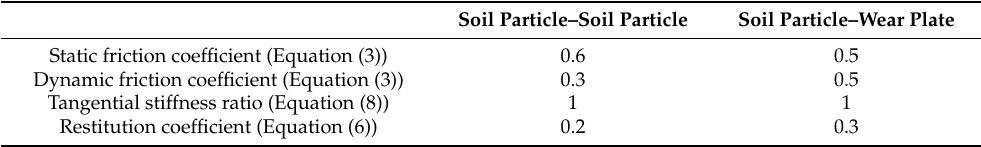
Table 2. Material interaction properties.